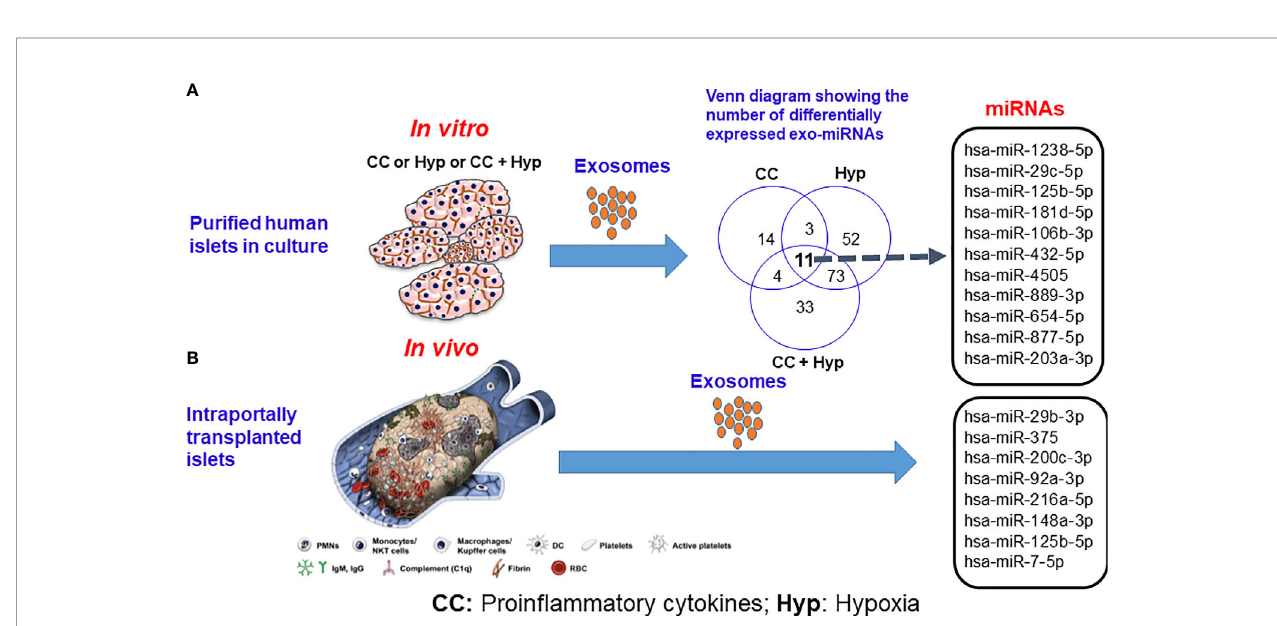
FIGURE 2 | Release of exosomal microRNAs from human islets subjected to proin fl ammatory cytokines and hypoxic conditions (A) in vitro and (B) following intraportal transplantation of autologous islets in vivo. Source: Saravanan et al., Diabetologia , 2019 (36). CC indicates proin fl ammatory cytokines; Hyp,